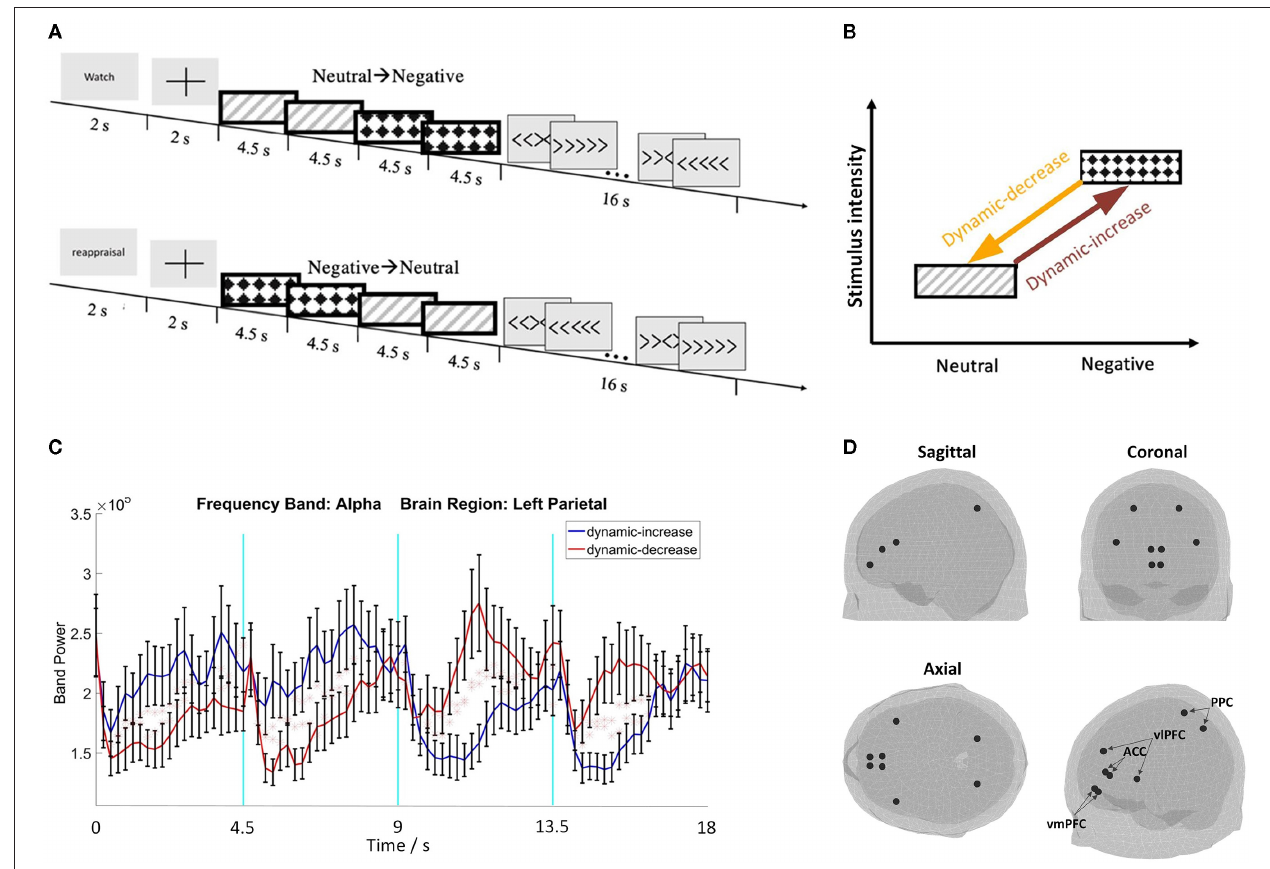
FIGURE 1 | (A) Schematic representation of the two image sequence conditions with the watch or reappraisal tasks; (B) schematic plot of the emotion transition elicited by image sequences from low to high intensity (i.e., dynamic increase) or from high to low intensity (i.e., dynamic decrease); (C) representative electroencephalography (EEG) waveforms with standard errors ( N = 32); (D) 3D brain maps of ROIs for source